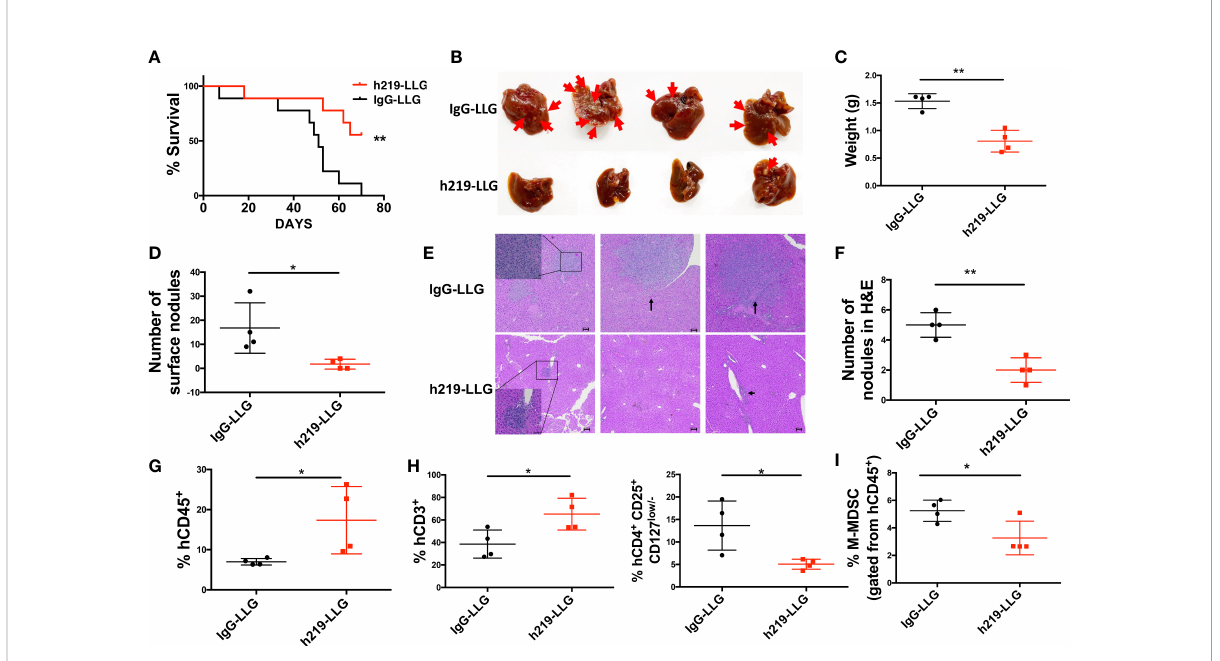
FIGURE 7 LAIR1 blockade reduces MDA-MB-231 tumor cell metastasis and prolongs survival in human cord blood CD34 + cell-reconstituted humanized mice. (A) Survival curve of mice treated by h219-LLG or control antibodies (n=9). (B) The pictures of livers from mice. Arrows indicate nodules formed by metastasized tumor cells. (C, D) The liver weight (C) and the number of surface nodules on livers (D) . (E, F) H&E staining of the tumor nodules in livers. (G, H) The percentages of tumor in fi ltrated hCD45 cells (G) , T cells (H left ) and Treg cells ( H right ) as determined by fl ow cytometry. (I) The percentages of M-MDSCs in bone marrow as determined by fl ow cytometry. As Statistical Analysis in Methods stated: * indicates p < 0.05; ** indicates p <